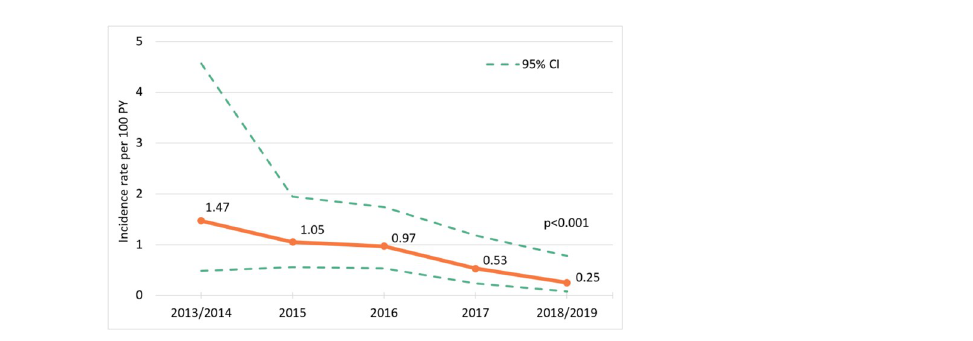
Fig 1. HIV incidence among GBMSM in the AURAH2 study, 2013–2019. AURAH2, The Attitudes to and Understanding of Risk of Acquisition of HIV 2; CI, confidence interval; GBMSM, gay, bisexual, and other men who have sex with men; PY, person-years.